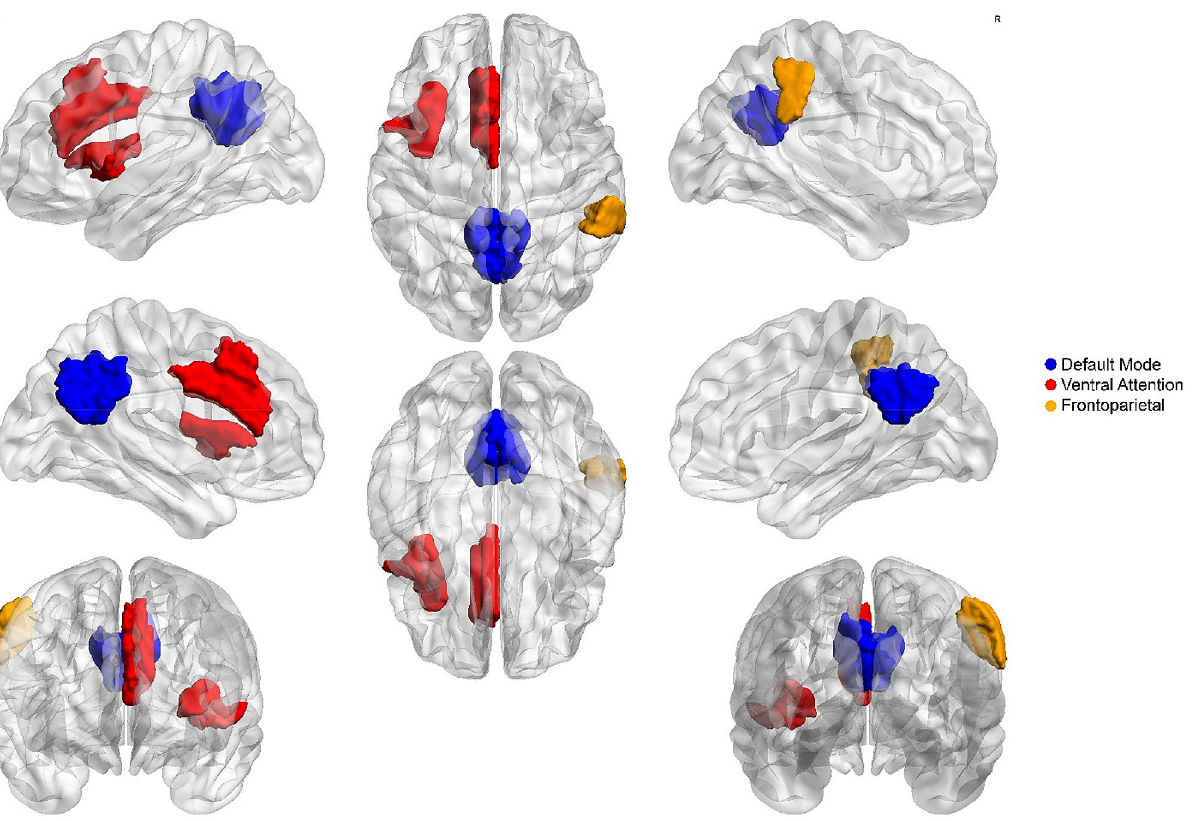
Figure 7. Emergence property of regions of interest. Colored portions of the brain images show regions that their negative degree distributions significantly differ from the whole-brain negative degree distribution (multiple comparisons corrected). Various colors denote that each region belongs to which large-scale cortical networks. The brain maps were created using BrianNet Viewer toolbox 30 of the Matlab (http://www.mathw orks. com/produ cts/matla